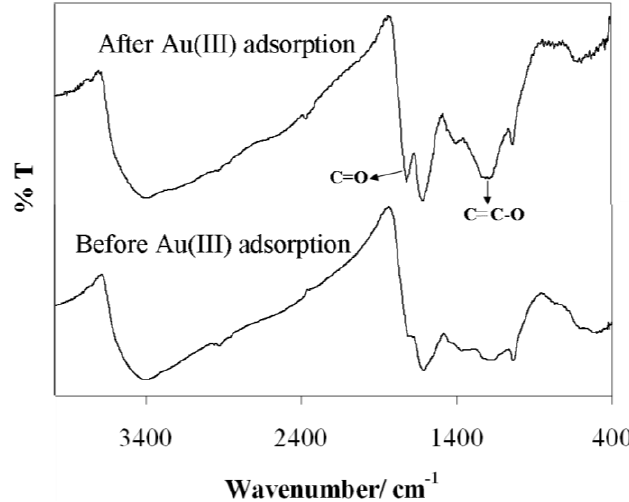
Figure 21. FT-IR spectra of CPT gel before and after the adsorption of gold(III) [33] (with permission for reuse from Elsevier